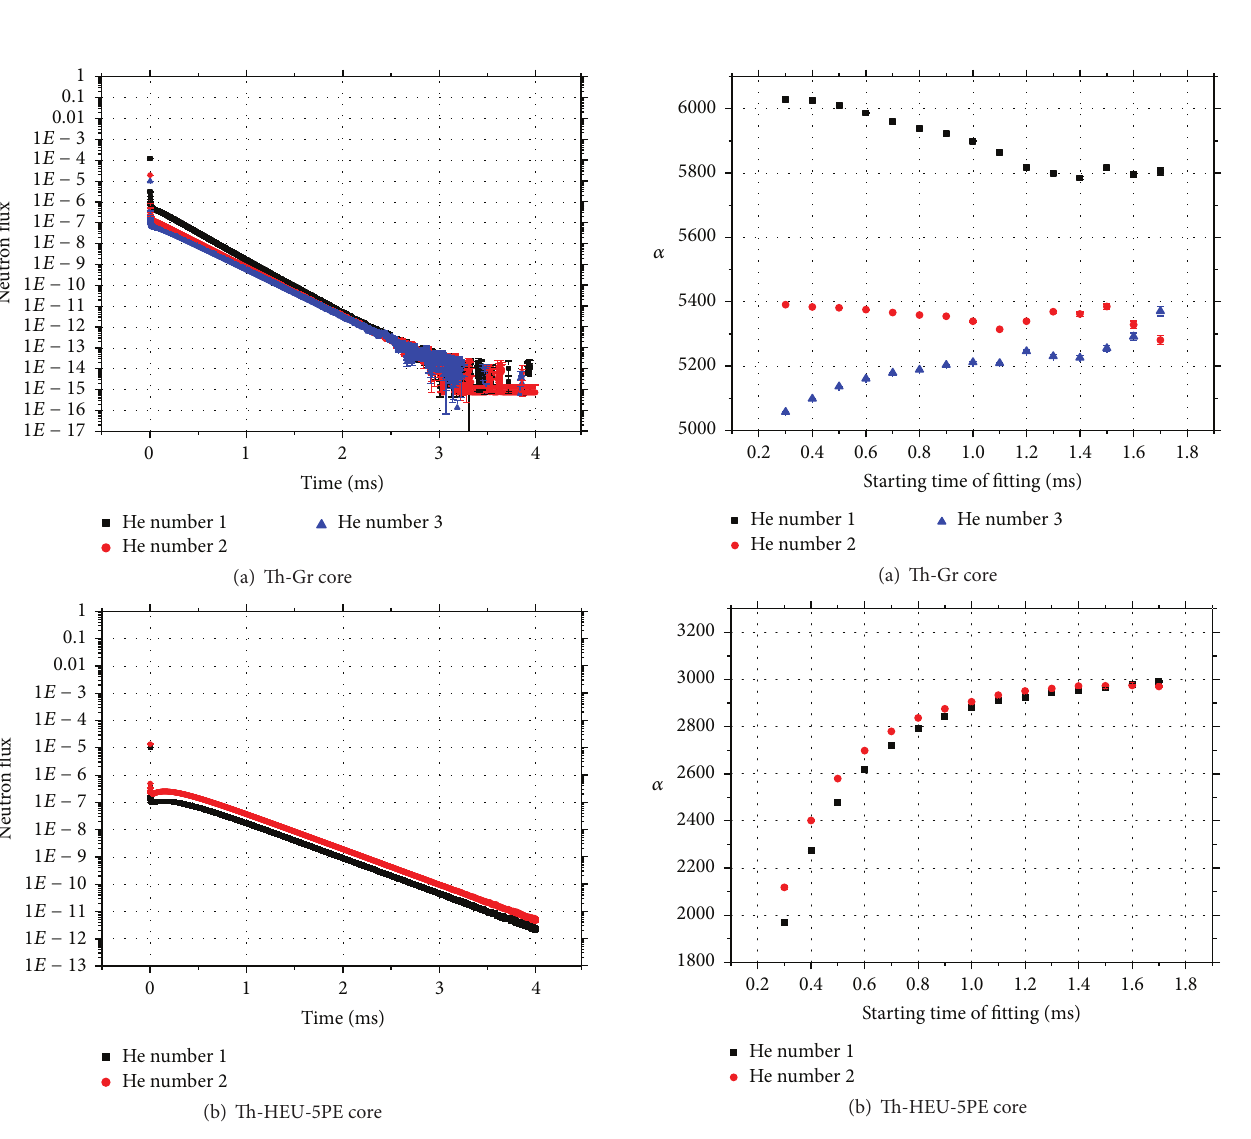
Figure 3: Time-dependent flux for the Th-ADS benchmark prob- lems.